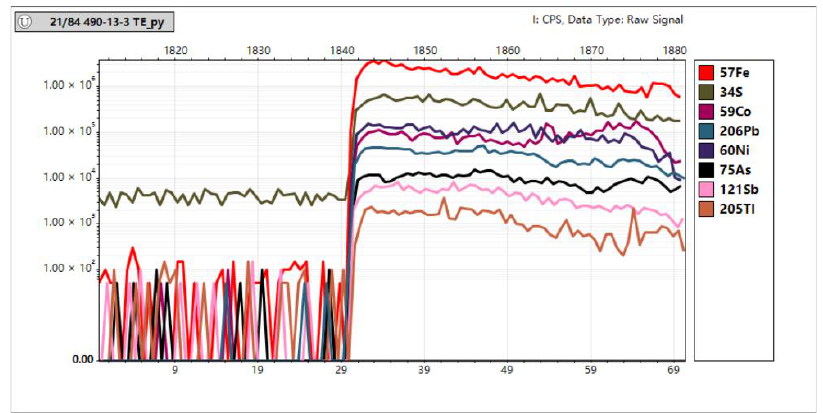
Figure 8. Time-resolved depth profiles of Pb, Tl, and Sb in Sample 490-28.